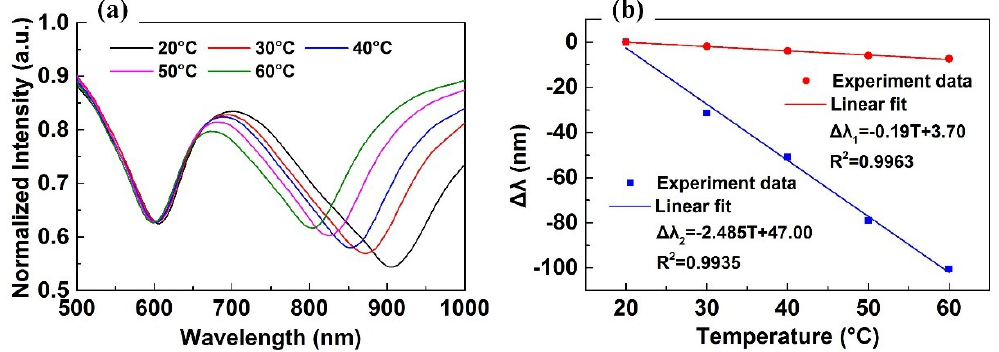
Figure 9. Fast Fourier transform (FFT) results of the original and unsmoothed SPR transmitted spectra.